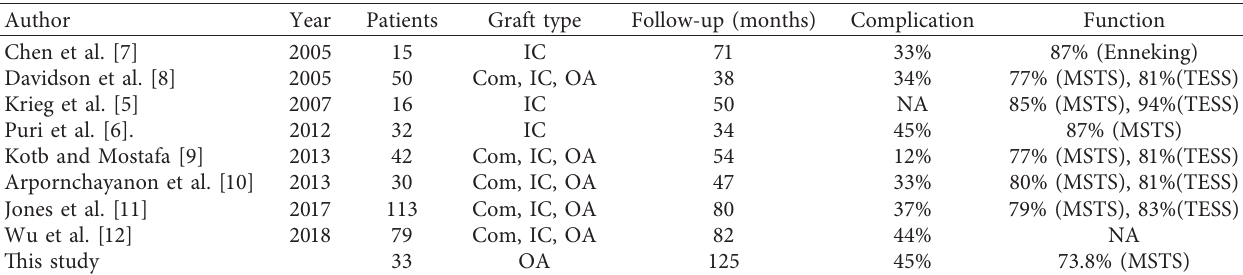
Figure 5: Case #23: 13-year-old male with osteosarcoma of the left distal femur. (a) Preoperative MRI. (b) 21 years after treatment with osteoarticular extracorporeal irradiated autograft. Collapse of the graft was not observed, and he did not undergo reoperation. Growth of the left tibia is preserved. The length of the left and right tibia is similar. The leg length discrepancy is Table 4: Comparative data with other published series of ECIA.